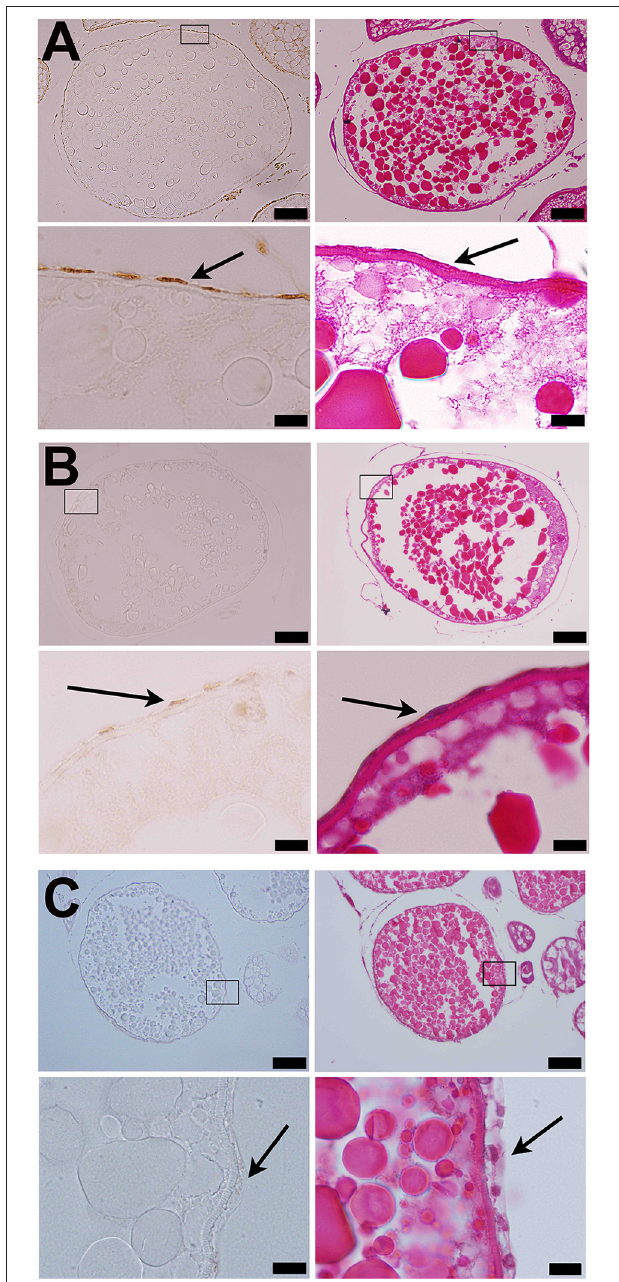
FIGURE 5 | Strong immunostaining of Adamts9 was observed in the follicular cells of wildtype ( wt ) fish (A) . (A) Representative images of a stage IVb follicle stained with hematoxylin and eosin or immunostained with an antibody against metalloproteinase domain of human ADAMTS9 (RP5-ADMTS-9, Triple Point Biologics, Forest Grove, Oregon), (B) Representative images of a stage IVb follicle of Pgr-KO zebrafish fish stained at same time, (C) Negative control, representative images of a stage IVb follicle of wildtype zebrafish fish stained at same time but the primary antibody was replaced with normal rabbit serum . Pictures located on the bottom of panels are magnified images of the areas outlined on the top panels. Immunostaining are shown on the left side of panels, while HE stains of adjacent sections are shown on the right side of panels. Arrows indicate follicular cells. Similar results were obtained when RP1-ADAMTS-9 antibody used (data not